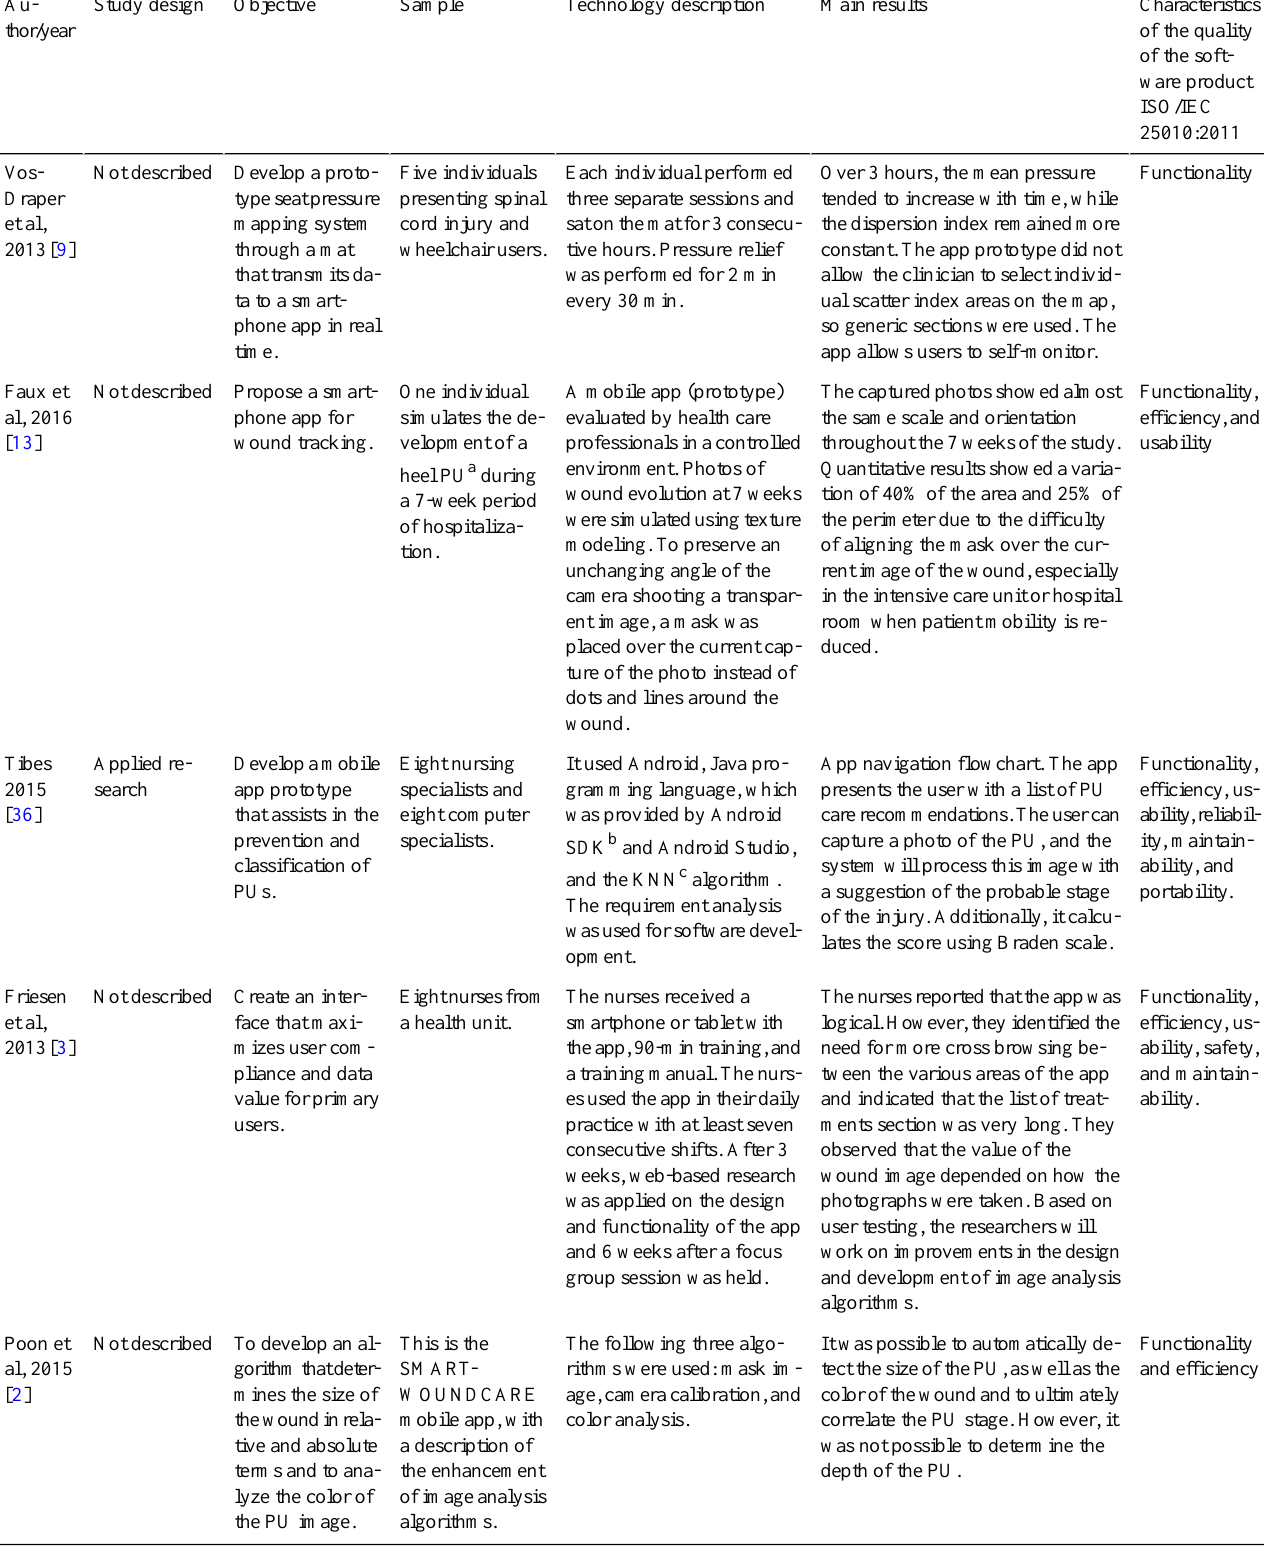
Table 2. Studies included for the qualitative synthesis of the systematic